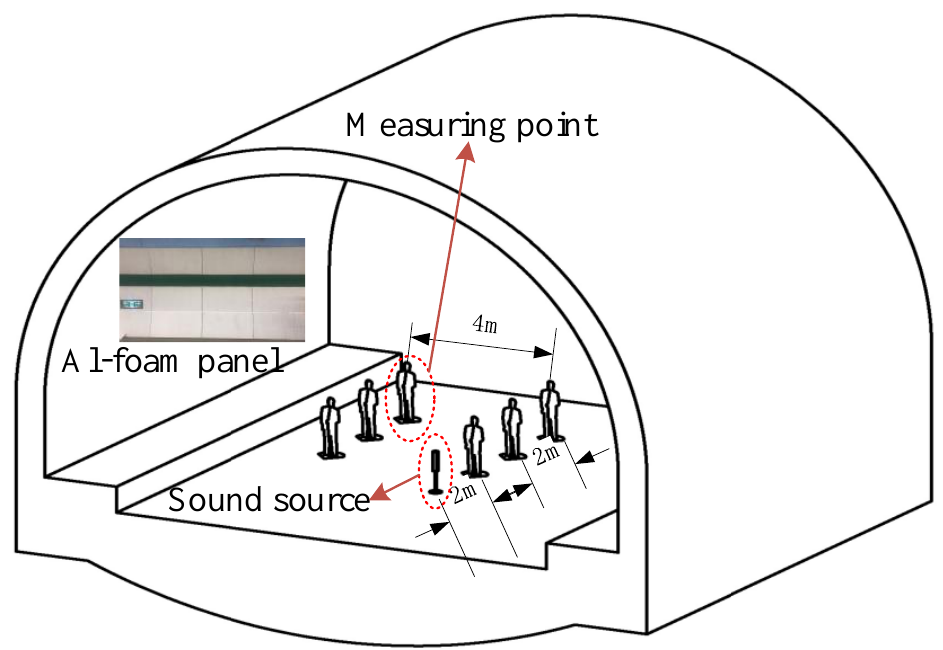
Figure 7. Sound source and measuring point layout.